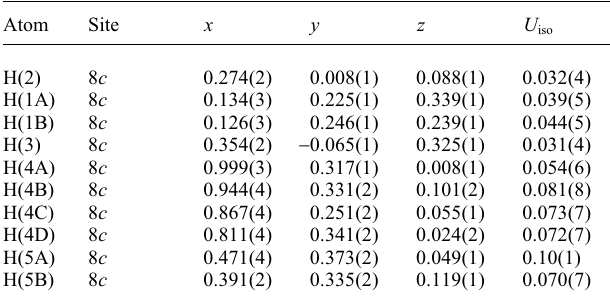
Table 2. Atomic coordinates and displacement parameters (in Å 2 )